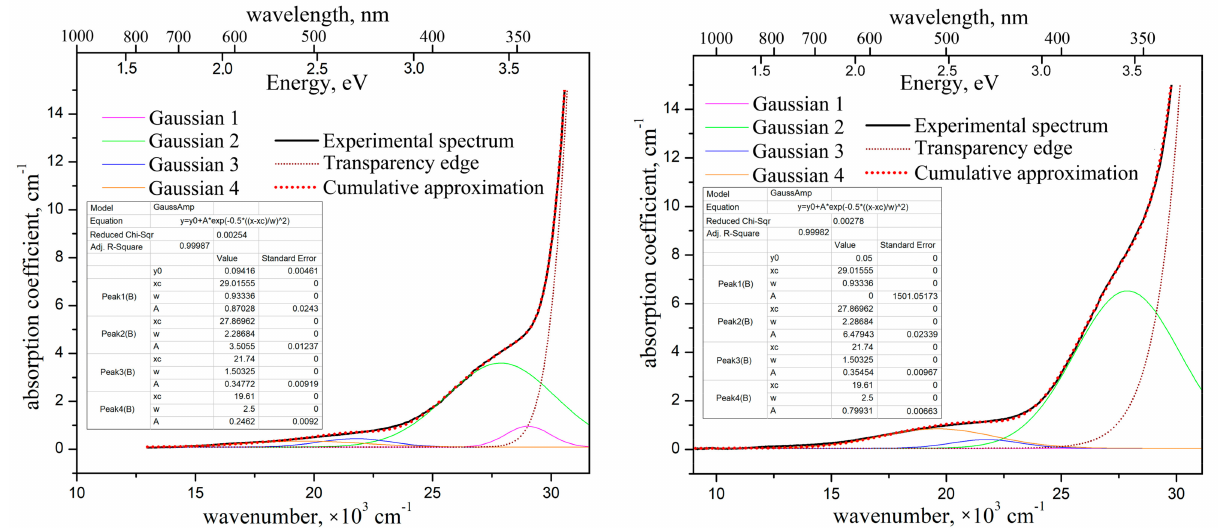
Figure 6. Optical absorption spectra of the “pure” ZnWO 4 crystal ( left ) and of the crystal-etalon ( right ), and their decomposition onto the elementary Gaussians. Polarization E (cid:107) N m + E (cid:107) N g , T = 300